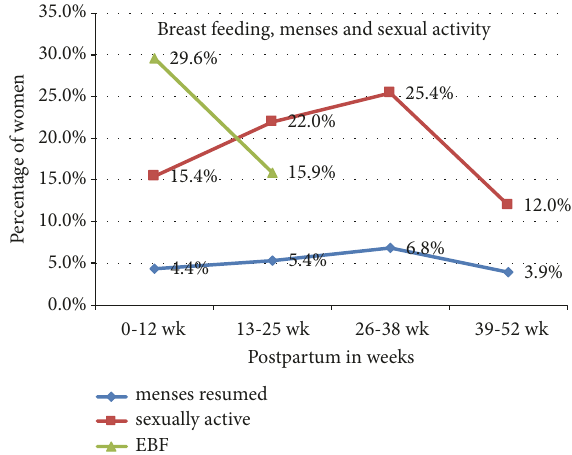
Figure 2: Exclusive breastfeeding, resumption of menses, and sexual activity of women in extended postpartum period in Tahtay Koraro, Ethiopia,